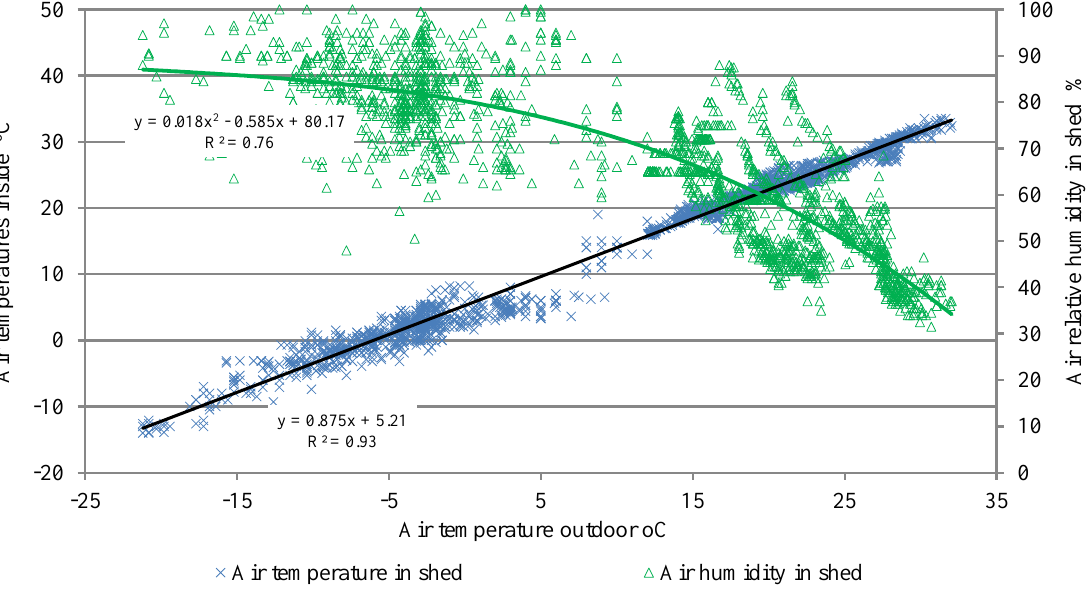
Figure 3. Air temperatures and relative humidity dynamics in uninsulated cowshed box-type (1 cowshed) related to outdoor temperatures .